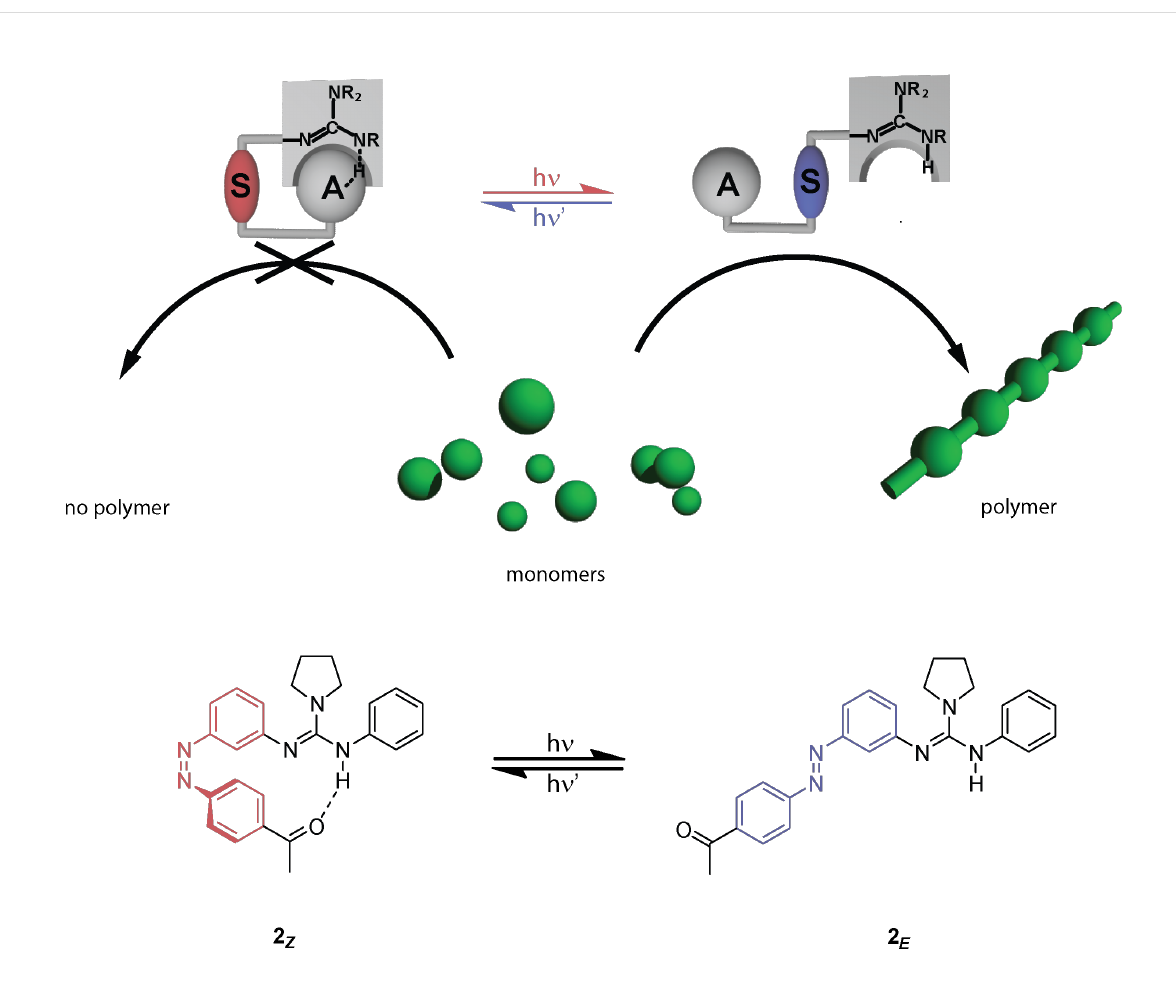
Scheme 2: Illustration of a photoswitchable guanidine catalyst for the ROP of lactide and the corresponding target structures 2 Z and 2 E (S = switching unit, A = H-bond acceptor).